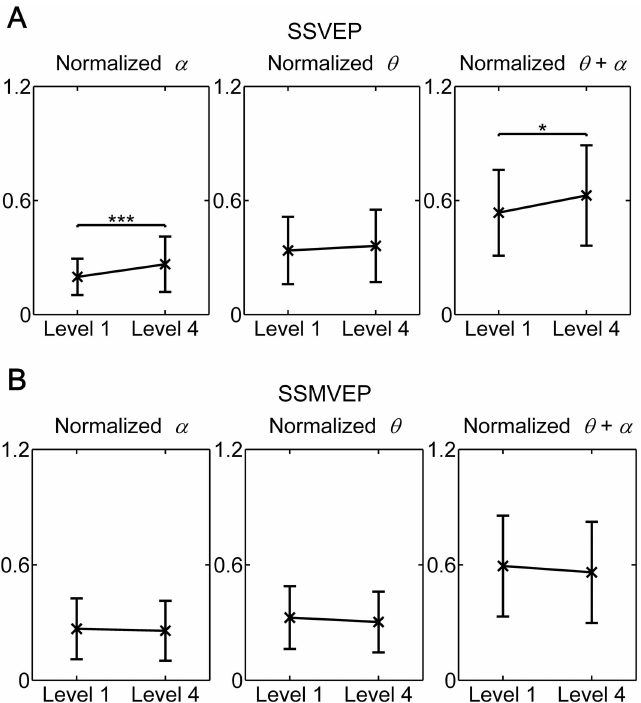
Fig 6. Comparison of the mean values and SD of fatigue score between fatigue level 1 and 4 in both of flickering SSVEP-BCI and motion-reversal SSMVEP-BCI conditions over subjects. (A) Comparison of fatigue between fatigue level 1 and 4 in SSVEP-BCI condition. (B) Comparison of fatigue between fatigue level 1 and 4 in SSMVEP-BCI condition. The mean values and SD of the normalizedpower indices α , θ and θ + α were calculated from ongoingEEG over nine subjects. Horizontal axis: Level 1—fatigue level 1 state; Level 4—fatigue level 4 state. All statistics were assessed by one-way ANOVA, *** p < 0.001